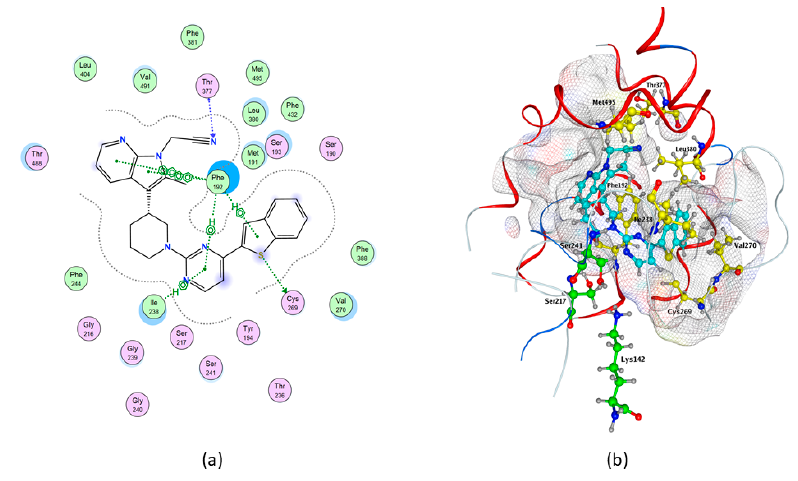
Figure 5. Best binding pose of QK5 within hFAAH Model1. ( a ) In the 2D structure the following details are shown: pi–H and pi–pi interactions, in green; backbone acceptor, in blue; solvent contact, in yellow. ( b ) In the 3D structure the following elements are reported as sticks: QK5, in cyan; catalytic triad, in green; all residues involved in the protein/ligand interaction, in yellow. Table 3. Docking results of QK5 and cannabinoid-derived compounds on